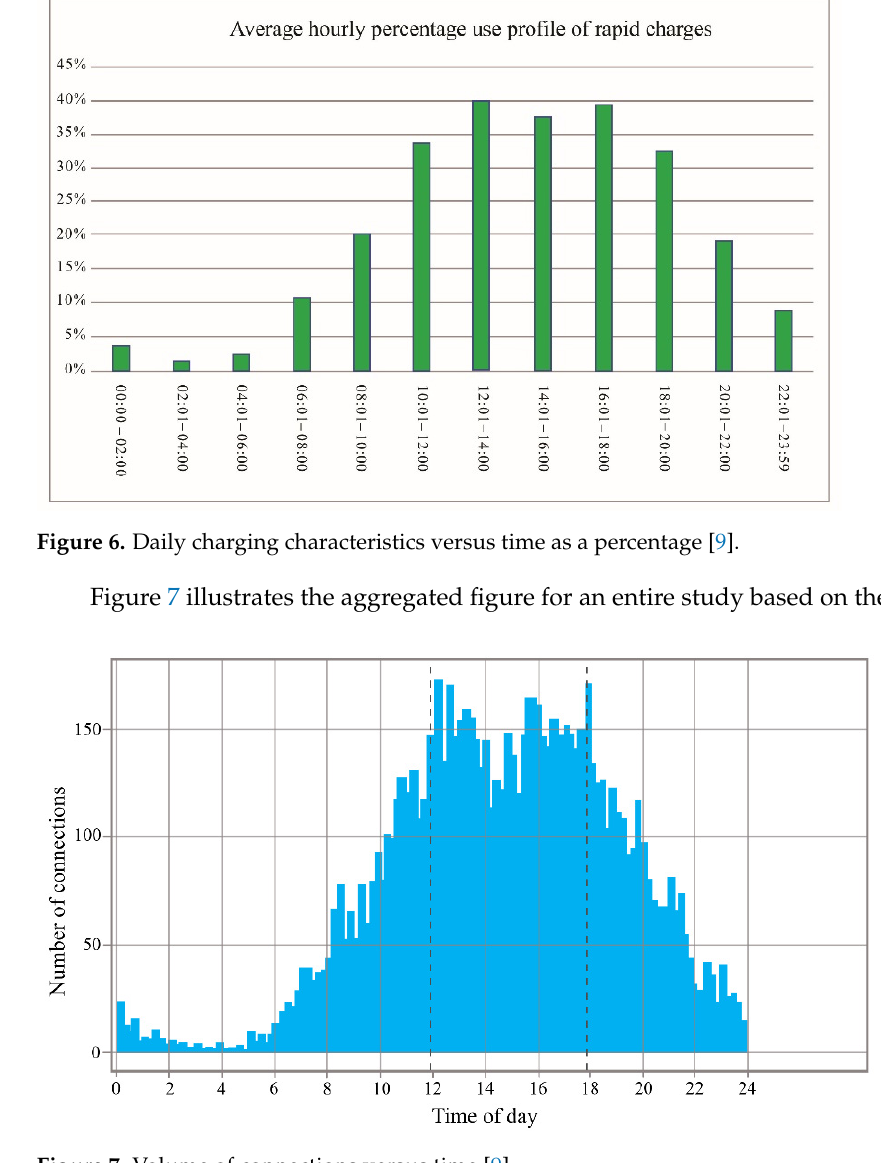
Figure 7. Volume of connections versus time [9].